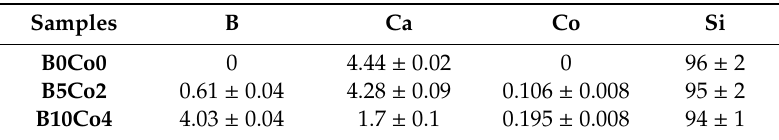
Table 2. Actual compositions of BCo.BGNs in mol% measured with inductively coupled plasma-optical emission spectrometry (ICP-OES).